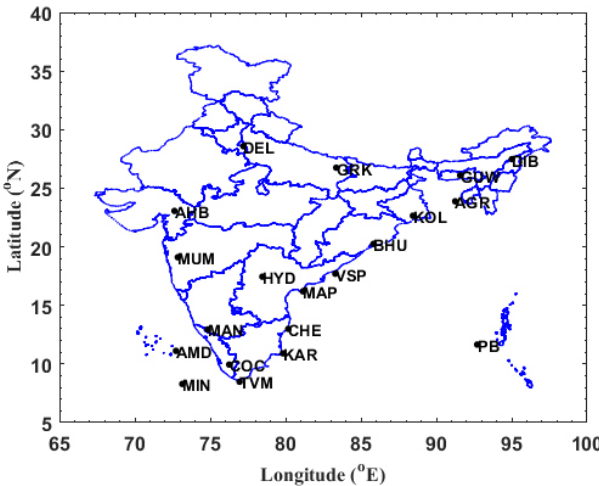
Figure 1. The geographical map of India representing the 20 sta- tions considered for the present